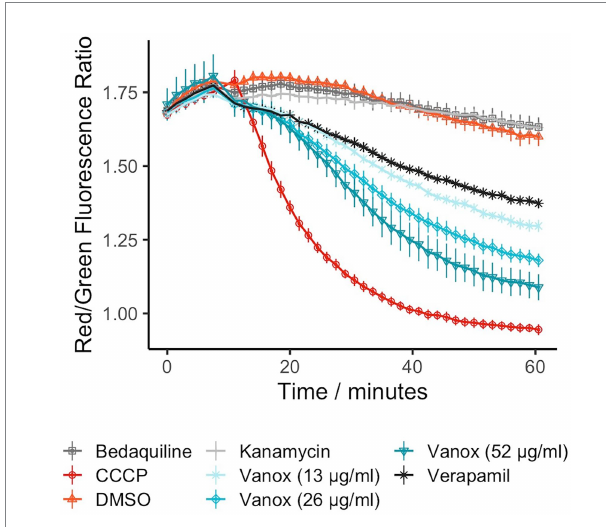
FIGURE 3 Vanoxerine disrupts the membrane potential of M. bovis BCG, disrupting already partitioned DiOC 2 (3) dye. Bedaquiline = 0.5 μ g/ml, CCCP = 25 μ M, DMSO = 1%, Kanamycin = 100 μ M, Verapamil = 50 μ g/ml. M. bovis BCG was incubated with 30 μ M DiOC 2 (3) for 2 h to allow dye partitioning across the membrane, the fluorescence was then measured for 10 min. Then either vanoxerine or controls were added, and the fluorescence was measured for a further 50 min. N = 3.